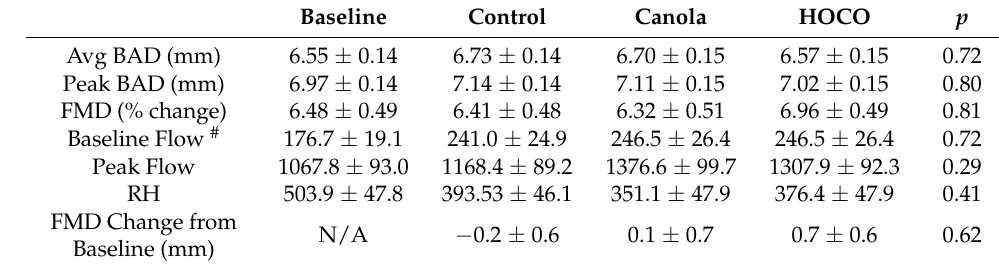
Table 3. Results of multilevel